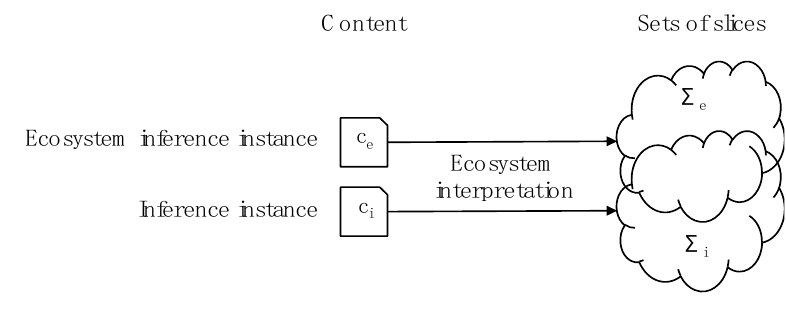
Figure 5. The quality of interim and output assertions.